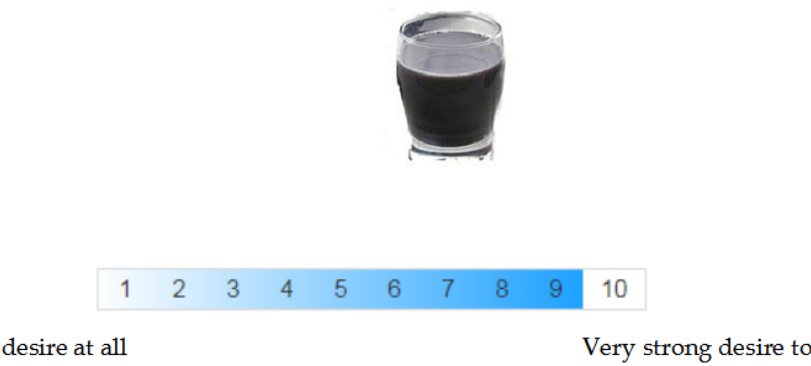
Figure A5. The picture of black bean products (Solid food).